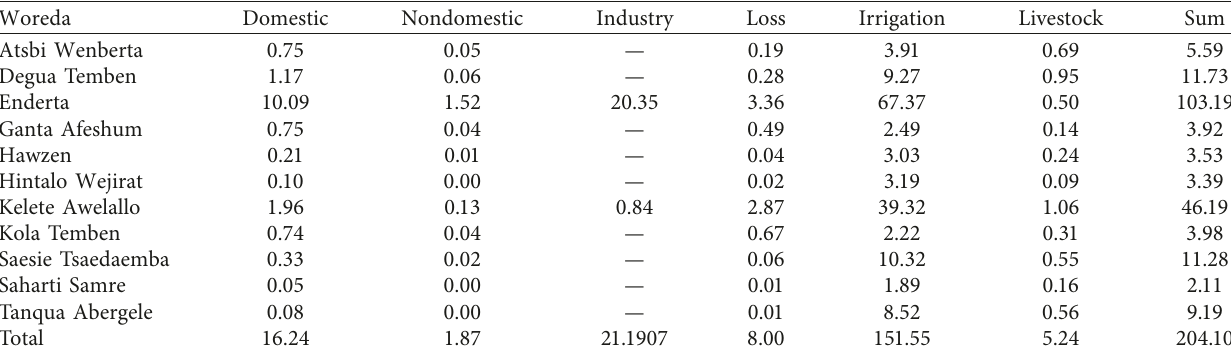
Table 12: Summery of all current water use in the subbasin in Mm 3